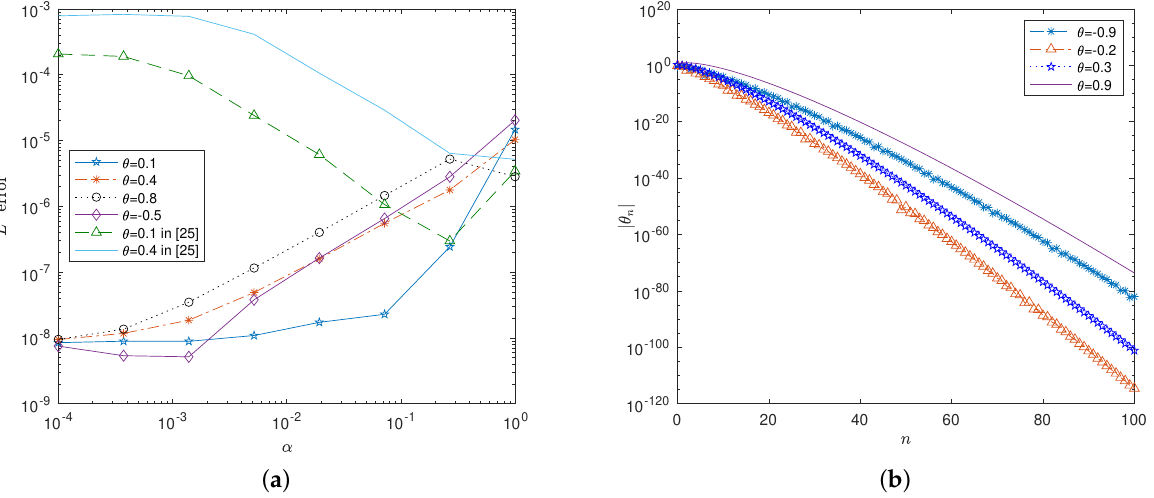
Figure 2. For Example 3. ( a ) Comparison of L 2 error between our scheme and that in [25] for different α . ( b ) Exponential decay of the weights | θ n | defined in